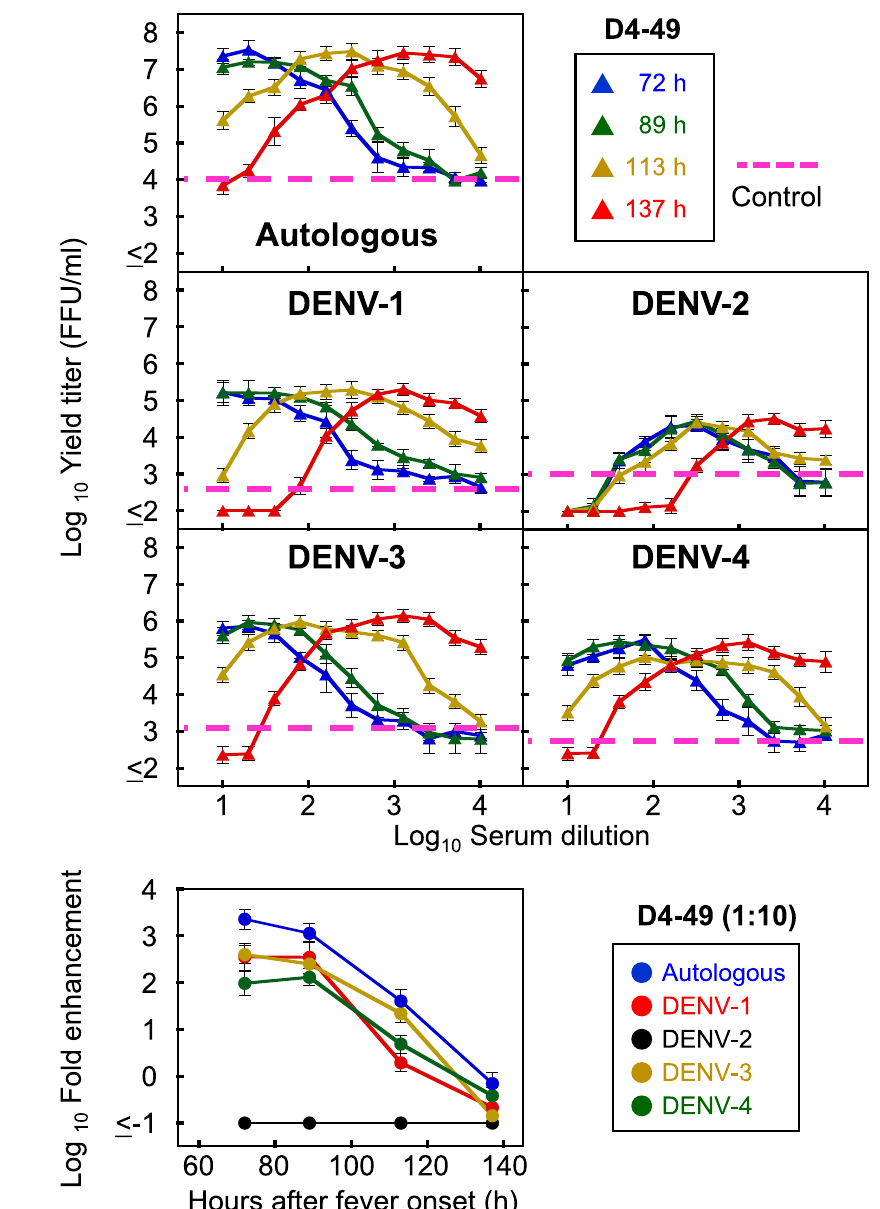
Figure 3. Progeny virus infectivity in the NAb/EAb balance assay. ( A ) Progeny virus titers obtained from the NAb/EAb-balance assay. The NAb/EAb-balance assay was conducted with combinations of patient D4-49 serum (twofold serial serum dilutions, starting from 1:10) and five DENV strains (the autologous, DENV-1: Mochizuki, DENV-2: NGC, DENV-3: H87 and DENV-4: H241 strain). Culture supernatants were harvested at 24 h after the mixture of serum, virus and K562 cells. The infective titers (FFU/ml) were determined on Vero cells. The blue , green , yellow and red triangles, corresponding to Fig. 1A, indicate the hours after fever onset. The abscissa indicates the serum dilutions and the ordinate shows the progeny virus titers (both expressed as log10). Dotted lines indicate the mean progeny virus titers calculated from four negative (no serum) controls. ( B ) Decreasing trend of ADE at low serum dilution with time progression. Fold enhancement was calculated from the infective progeny virus titers obtained in ( A ) (specifying data at 1:10 serum dilution), and was expressed in log10 as the increase in the progeny virus titer relative to the negative control. The fold enhancement was plotted as the ordinate against time (h) as the